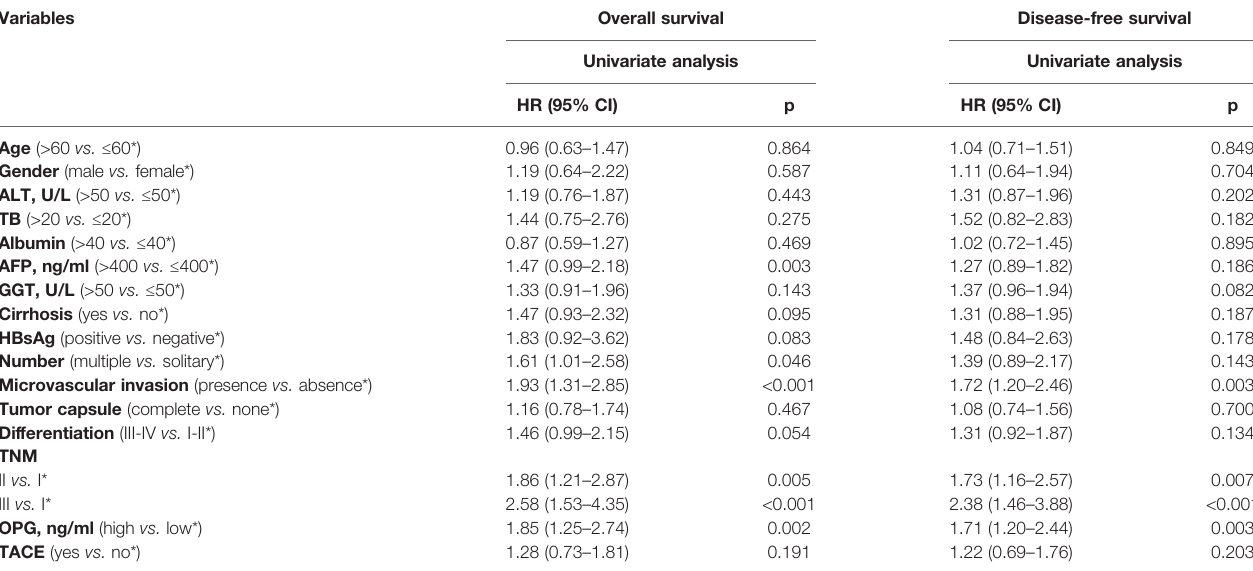
TABLE 4 | Univariate Cox regression analysis for assessing the effect of different clinical variables on HCC patients ’ overall survival and disease-free survival in the matched population. Variables